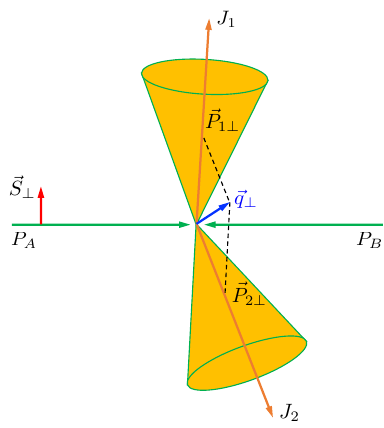
Figure 1 . Illustration of back-to-back dijet production in transversely polarized proton-proton collisions: p ( P A , ~S ⊥ ) + p ( P B ) → J 1 ( y c , ~P 1 ⊥ ) + J 2 ( y d , ~P 2 ⊥ ) + X . The polarized proton with mo- mentum P A and transverse spin ~S ⊥ is moving in + z -direction, while the unpolarized proton with momentum P B is moving in − z -direction. We have jet rapidities y c,d and transverse momenta ~P 1 ⊥ and ~P 2 ⊥ , respectively. The dijet transverse momentum imbalance is defined as ~q ⊥ = ~P 1 ⊥ + ~P 2 ⊥ . Sivers asymmetry is generated due to the correlation between ~S ⊥ and ~q ⊥